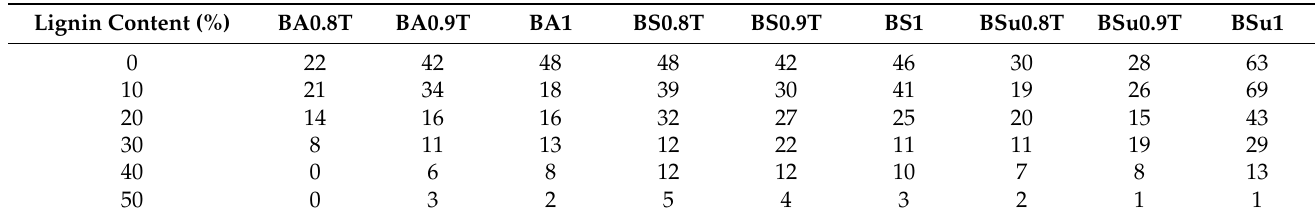
Table 7. Crystallinity (%) determined by XRD of the various lignin-co-polyester/amides.